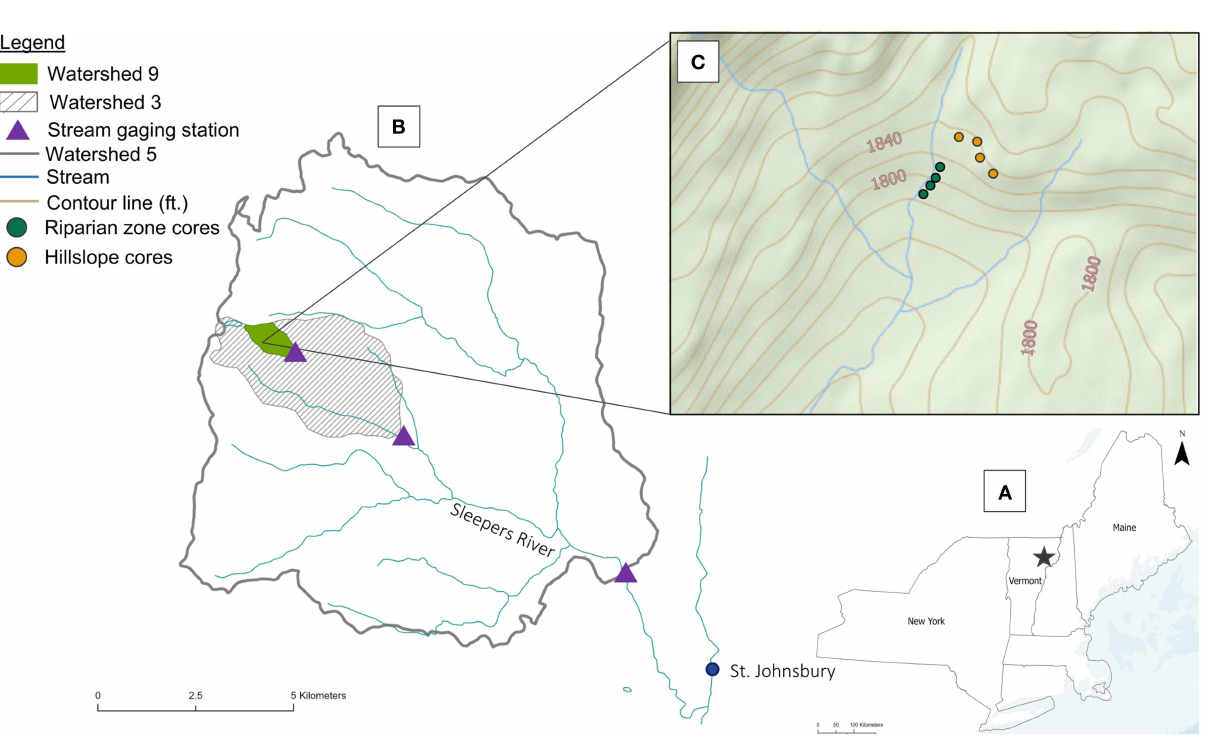
FIGURE1 (A) Location of field site in the northeastern United States. (B) Sleepers River Watershed in northeastern Vermont (gray outline), Watershed 3 (gray hatched), and the forested watershed—Watershed 9 (green shaded). (C) Location of soil core sampling sites. Hillslope samples are represented by orange circles, riparian by green circles. Modified from Shanley et al.